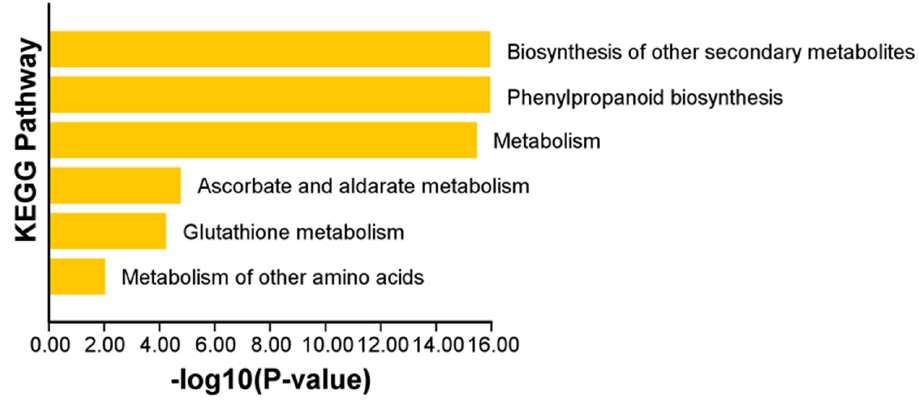
Figure 7. KEGG enrichment analysis of ClPRXs in